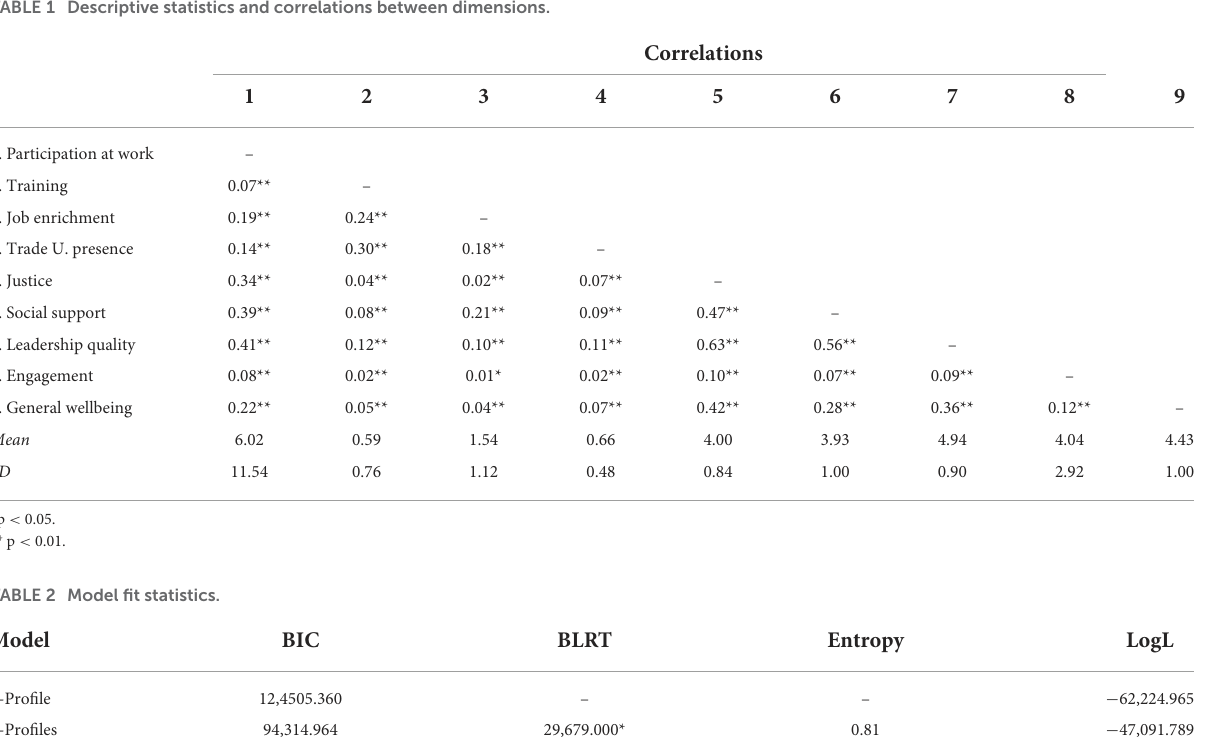
TABLE 1 Descriptive statistics and correlations between dimensions.